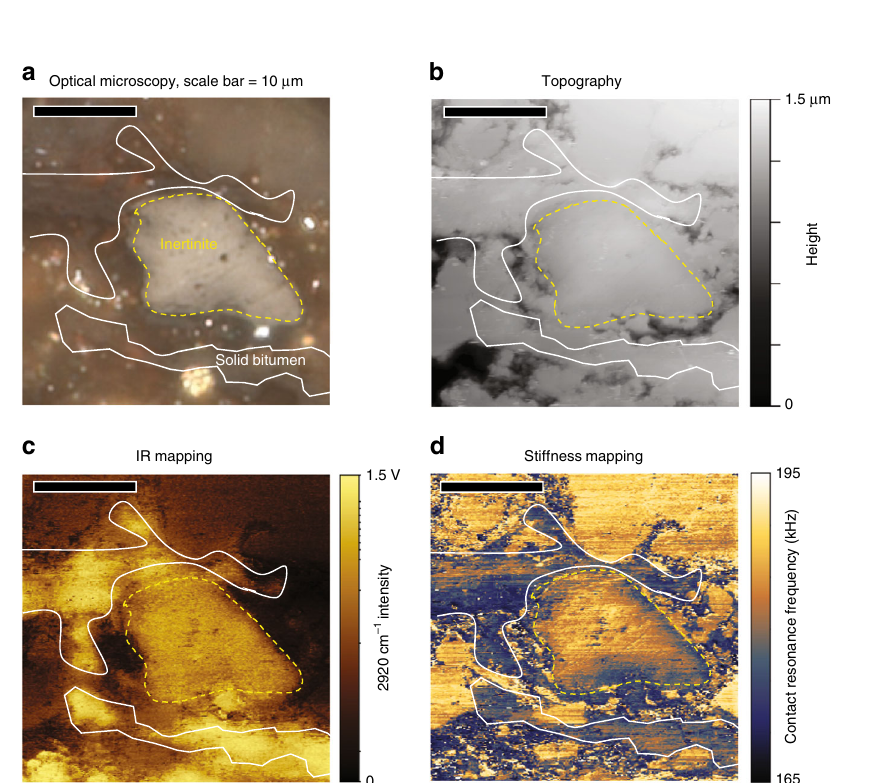
Fig. 1 Correlative imaging of distinct inertinite and solid bitumen. a Photomicrograph (white incident light, oil immersion) of organic matter in polished, low maturity (BR o , 0.25%) New Albany Shale sample, showing bright re fl ectance inertinite surrounded by solid bitumen in an scanned area of 30 × 30 μ m 2 . b Topographic image of same fi eld, showing a smoothly polished surface, with no relief between organic and inorganic phases. c Same fi eld showing IR absorption mapping of aliphatic C – H stretching (2920 cm − 1 ). d Mechanical stiffness mapping of same fi eld at 2920 cm − 1